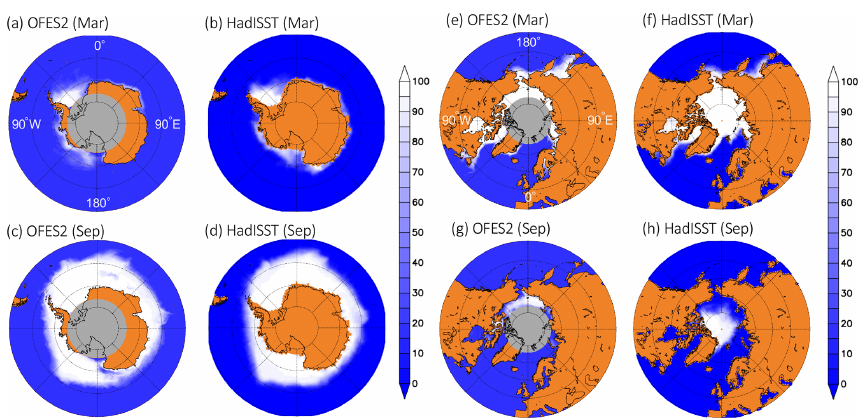
Figure 9. Sea-ice concentrations (%) in the Antarctic Ocean in (a, b) March and (c, d) September in (a, c) OFES2 and (b, d) HadISST averaged over 2005–2012. Similarly, the sea-ice concentrations in the Arctic Ocean in (e, f) March and (g, h) September in (e, g) OFES2 and (f, h) HadISST. The gray areas are out of the model domain in OFES2 (a, c, e, g) . Table 2. (a) RMS amplitude ( ◦ C) of the Niño3.4 index and the DMI for OFES2, OFES, and HadISST as well as their correlations between OFES2 and HadISST and between OFES and HadISST. (b) Same as (a) but the eastern and western pole DMIs. (a) OFES2 OFES HadISST RMS amplitude of the Niño3.4 index ( ◦ ) 0.95 0.93 0.89 Correlation with the Niño3.4 in HadISST 0.963 0.880 – RMS amplitude of the DMI ( ◦ ) 0.52 0.38 0.32 Correlation with the DMI in HadISST 0.714 0.659 – (b) OFES2 OFES HadISST RMS amplitude of the eastern pole DMI( ◦ ) 0.43 0.33 0.33 Correlation with the eastern pole DMI in HadISST 0.713 0.749 – RMS amplitude of the western pole DMI ( ◦ ) 0.31 0.41 0.33 0.847